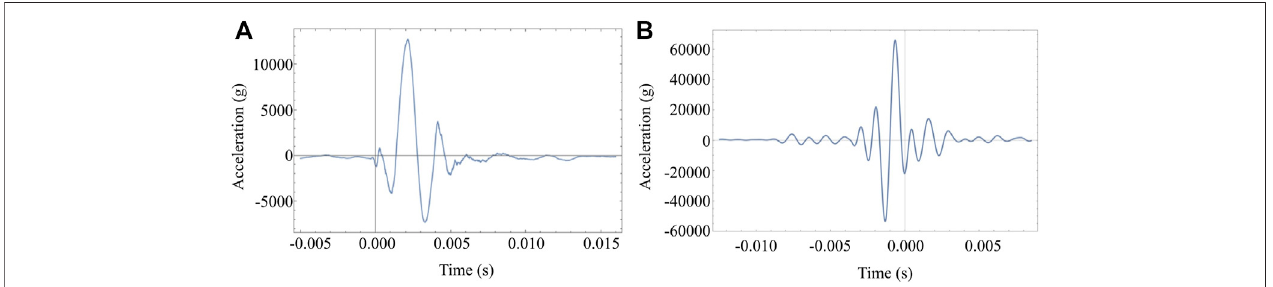
FIGURE 3 | Acceleration pro fi le plots from the fi rst and third impact tests. The zero-point of the x -axis is arbitrary, making the axis useful for viewing the duration of the pulse during the impact event. (A) 12.7 k-g acceleration data after applying a low pass fi lter at 550 Hz. (B) 66 k-g acceleration data after applying a low pass fi lter at 1,000